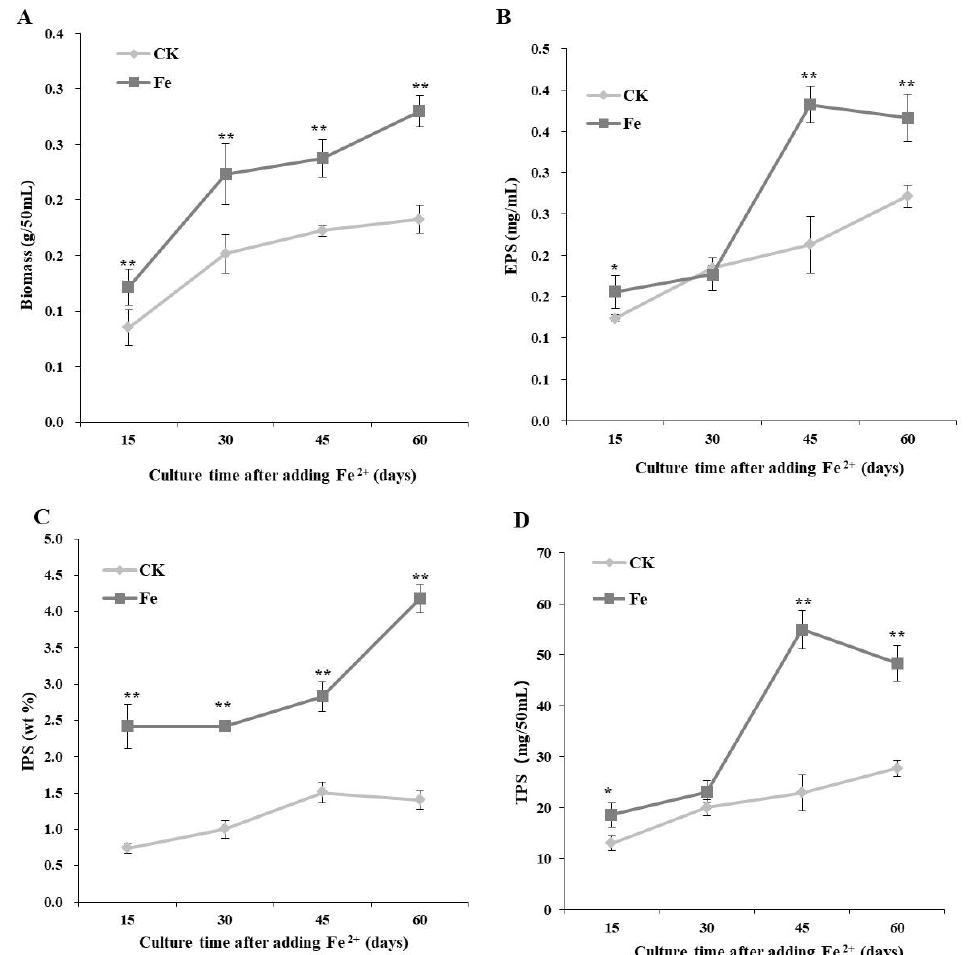
Figure 2. Dynamic changes in biomass ( A ), extracellular polysaccharide (EPS, ( B )), intracellular polysaccharide (IPS, ( C )), and total polysaccharide (TPS, ( D )) production by the Lentinula edodes strain 808 (ACCC 52357) over 70 days of static cultures. CK: control without Fe 2+ ; Fe: as FeCl 2 , 200 mg/L of Fe 2+ was added after 7 days of shaking at 150 rpm and 3 days of static culture. The time on the abscissa represents the incubation time after the addition of Fe 2+ . Data are the means of experiments in triplicate. Asterisks indicate a significant statistical difference at p < 0.01 (**) and p < 0.05 (*), according to the LSD test.